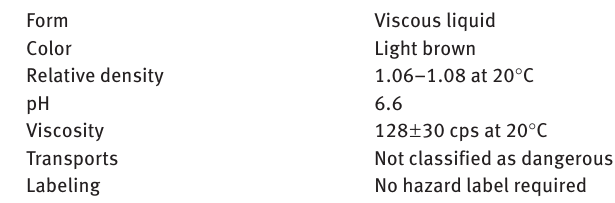
Table 2 Physical properties of fine and coarse aggregates.